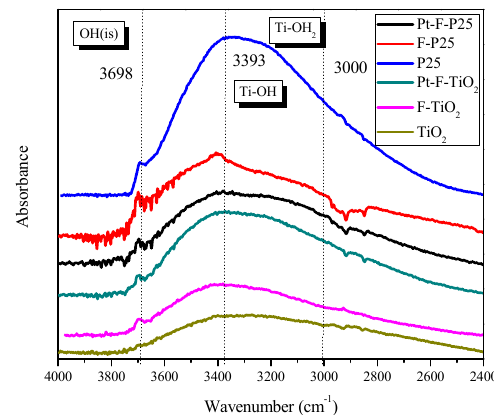
Figure 5. FTIR spectra for the photocatalysts analyzed.